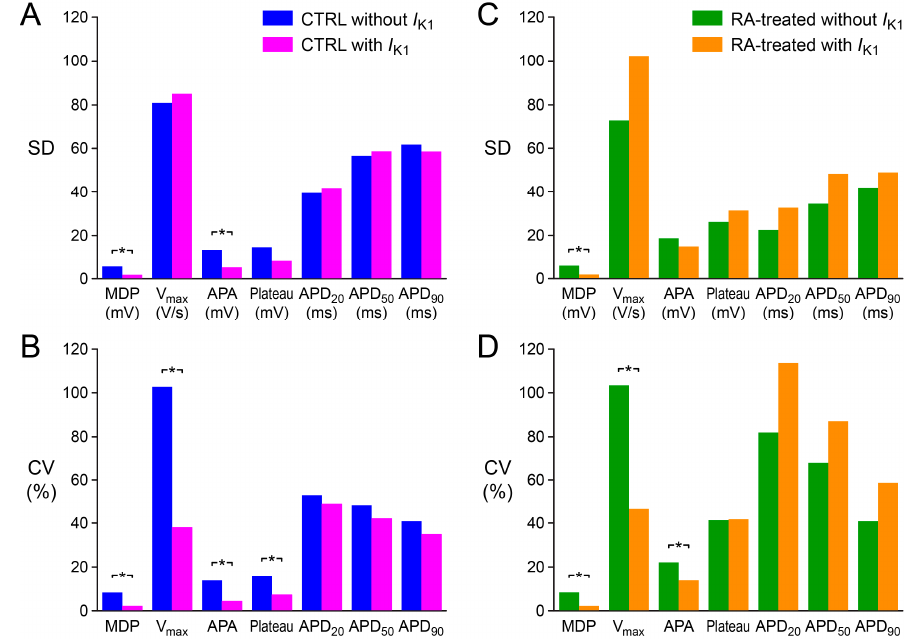
Figure 6. Variability in action potential parameters of the CTRL and RA-treated hiPSC-CMs, both with and without I K1 injection. ( A ) Standard deviation (SD) and ( B ) coefficient of variation (CV) of the AP parameters of the CTRL hiPSC-CMs. ( C ) SD and ( D ) CV of the AP parameters of the RA-treated hiPSC-CMs. MDP: maximum diastolic potential; V max : maximum upstroke velocity; APA: action potential amplitude; Plateau: AP plateau amplitude; APD 20 , APD 50 , and APD 90 : action potential duration at 20%, 50%, and 90% repolarisation, respectively. * p < 0.05.